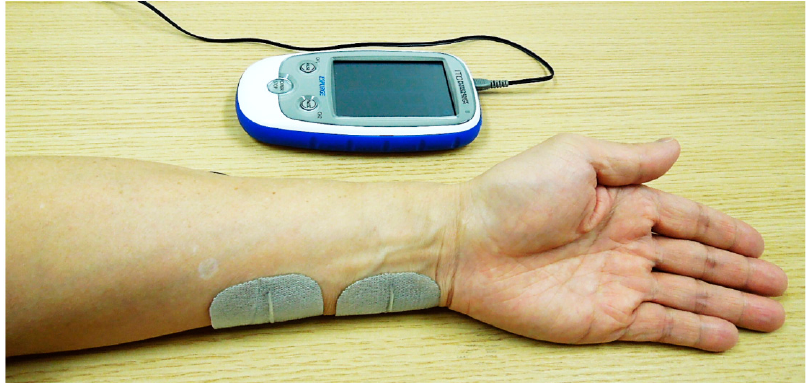
Figure 1. Position of the electrode attachment during electrical stimulation.